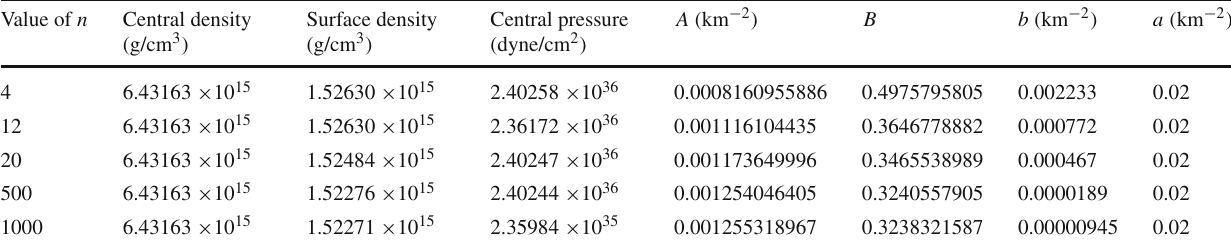
Table 1 Physical parameters for different values of n for the star with mass = 2.01 ( M θ ) and predicted radius (R) = 7 km Value of n Central density Surface density Central pressure (g/cm 3 ) (g/cm 3 ) (dyne/cm 2